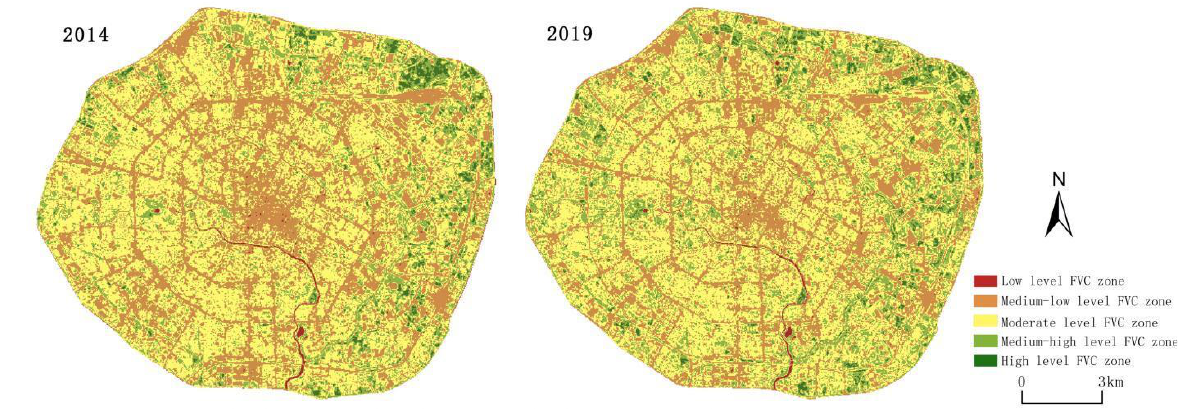
Figure 7. Spatial distribution of FVC grades within the Third Ring Road of Chengdu in 2014 and